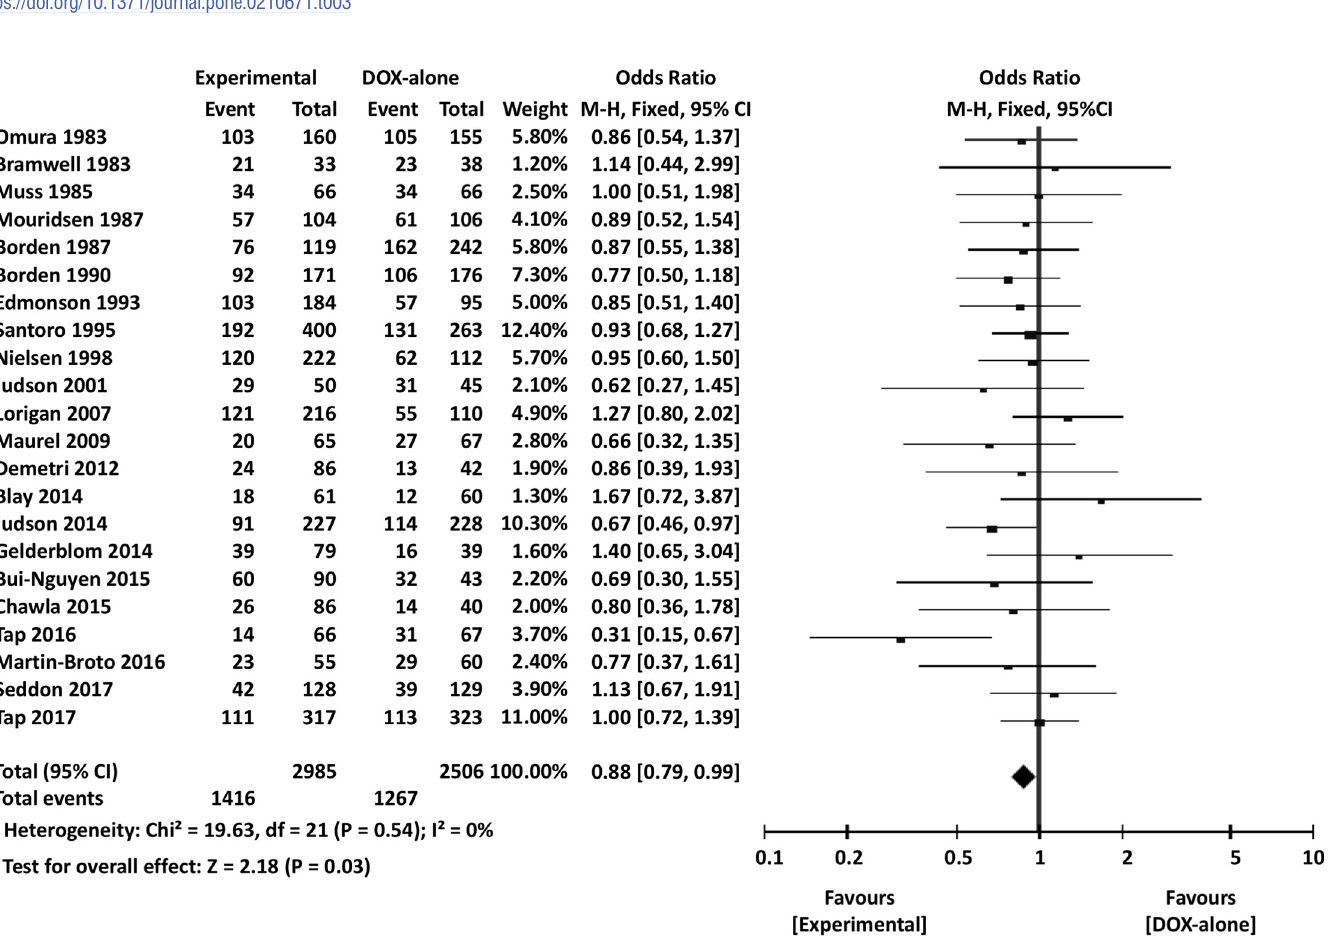
Fig 4. Comparisons of doxorubicin alone vs experimental chemotherapy: Forest plots of 1-year overall survival. M-H, Mantel-Haenszel; CI, confidence interval.